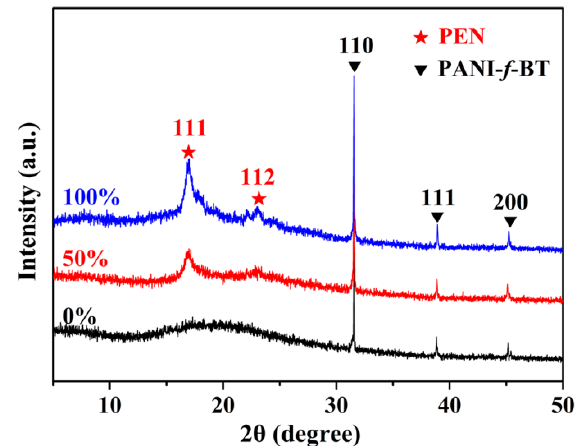
Figure 7. The wide-angle XRD patterns of PEN/PANI- f -BT-b at different stretching ratios.